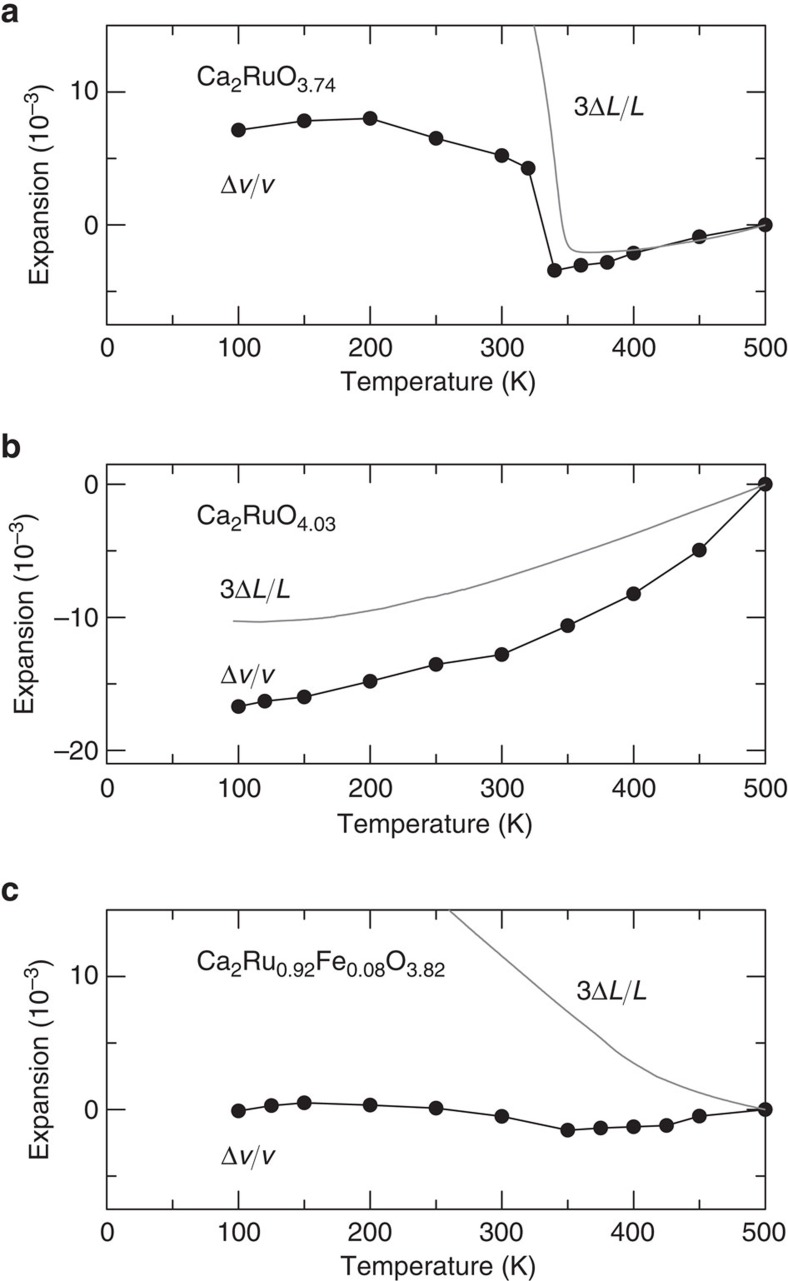
Volumetric thermal expansion of Ca2Ru1−xMxO4+y.(a) Ca2RuO3.74, (b) Ca2RuO4.03 and (c) Ca2Ru0.92Fe0.08O3.82. Results estimated from crystallographic (Δv/v) measurements are compared with the dilatometry (3ΔL/L) results. Reference temperature: 500 K. The discrepancy is conspicuous when the dilatometric negative thermal expansion becomes large.